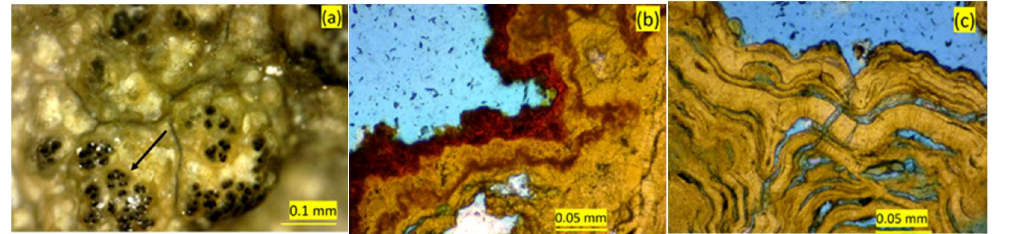
Figure 5. Micrographs of Valen samples: ( a ) surface of the mineral crust showing botryoidal formations with dark agglomerations (arrow), ( b ) cross-section of the crust showing lamina and likely formation of iron oxides/hydroxyoxides on the surface as weathering products of the jarosite (dark red material at the surface), and ( c ) polished thin section showing laminated crust structure. The scale is 0.1 mm in ( a ) and 0.05 mm in ( b , c ), respectively.